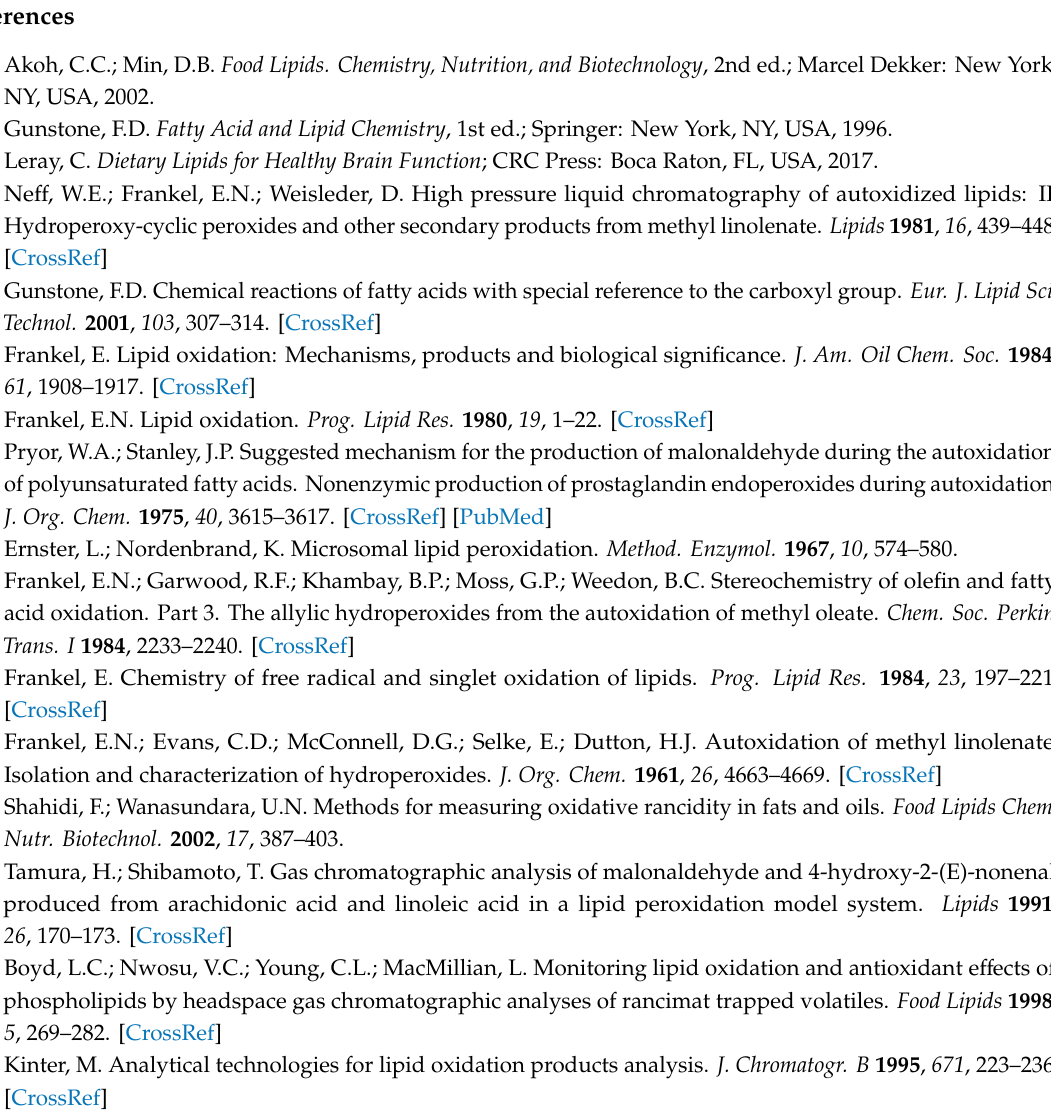
Table S3: Comparison of computational [B3LYP / 6-311G + d (2d, p)] 1 H-NMR chemical shifts of the 10-cis, 13-cis, 15-trans-16-OOH hydroperoxide model, with energy minimization at the APFD / 6-31 + G(d) level, with the experimental chemical shifts of the full length molecule, Table S4: Comparison of experimental and computational 1 H-NMR chemical shifts of the full length diastereomeric 9-cis, 11-trans-l6-OOH endo-hydroperoxides with energy minimization at the APFD / 6-31 + G(d):PM6 level, Table S5: Conformational and structural properties of the full length diastereomeric 9-cis, 11-trans-16-OOH endo-hydroperoxides with energy minimization using the APFD / 6-31 + G(d):PM6 method, Table S6: 1 H-NMR chemical shifts of hydroperoxides of methyl